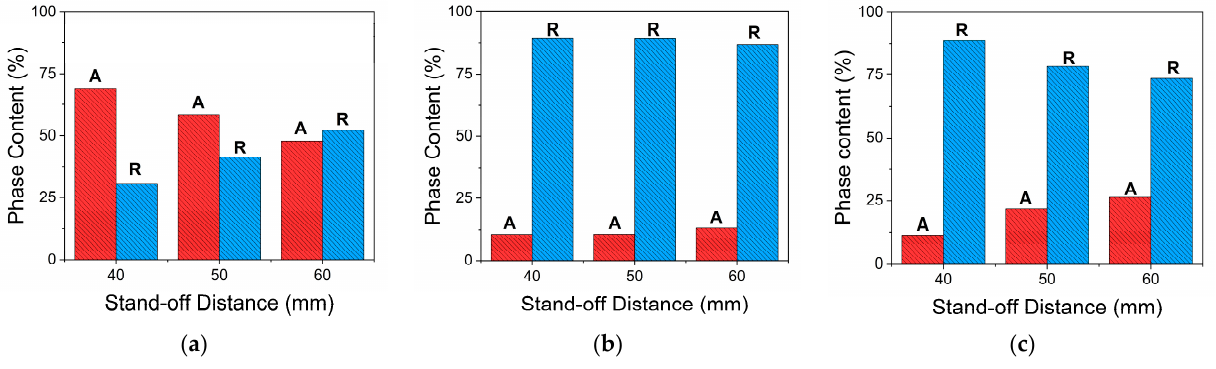
Figure 9. Anatase (A) and rutile (R) phase content percentages in ( a ) FS1, ( b ) FS2, and ( c ) FS3 coatings as a function of stand-off distance.